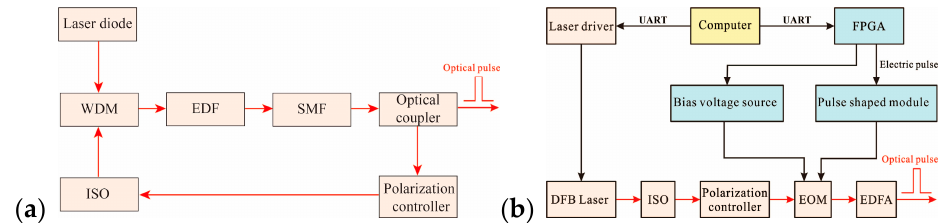
Figure 2. Schematic diagram of the optical pulse modulation scheme; ( a ) traditional optical pulse modulation scheme; ( b ) Field-programmable gate array (FPGA)-based optical pulse modulation scheme.